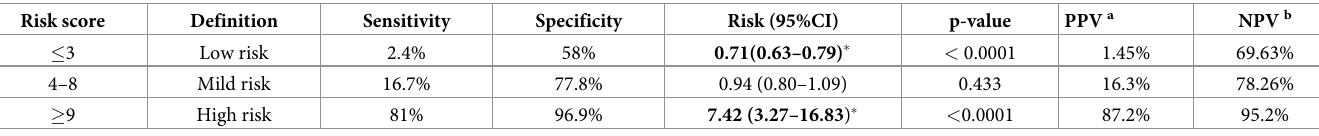
Table 6. Risk Scores